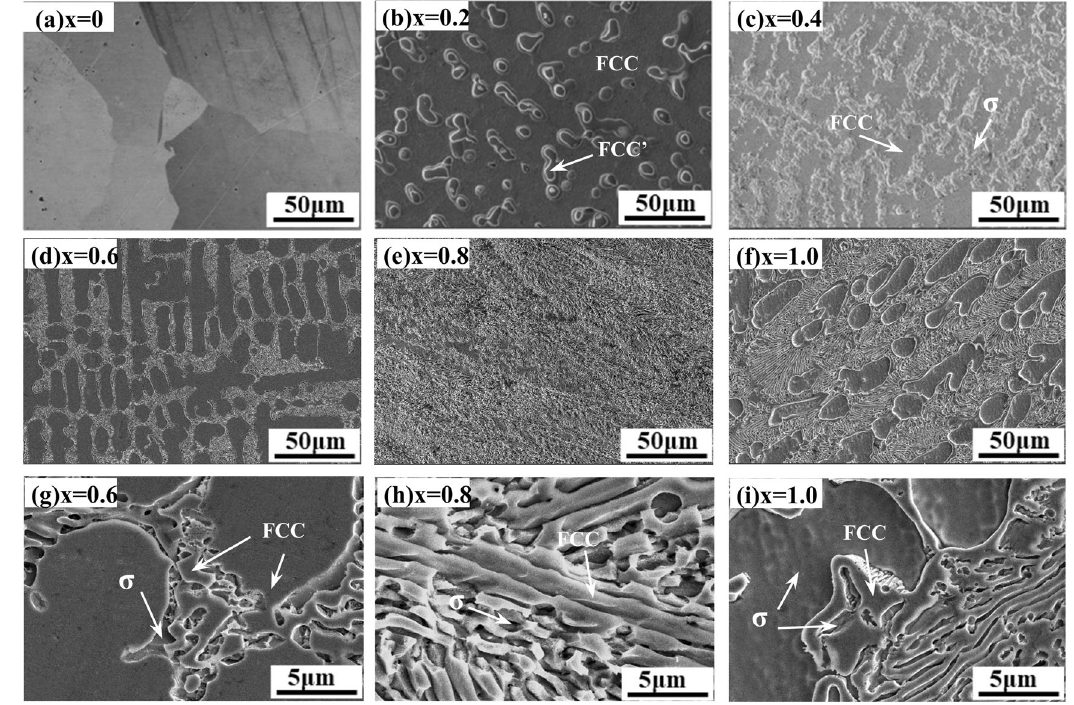
Fig. 2 SEM images of CoCrFeNiMo x HEAs. SEM images of a Mo 0 , b Mo 0.2 , c Mo 0.4 , d and g Mo 0.6 , e and h Mo 0.8 , f and i Mo 1